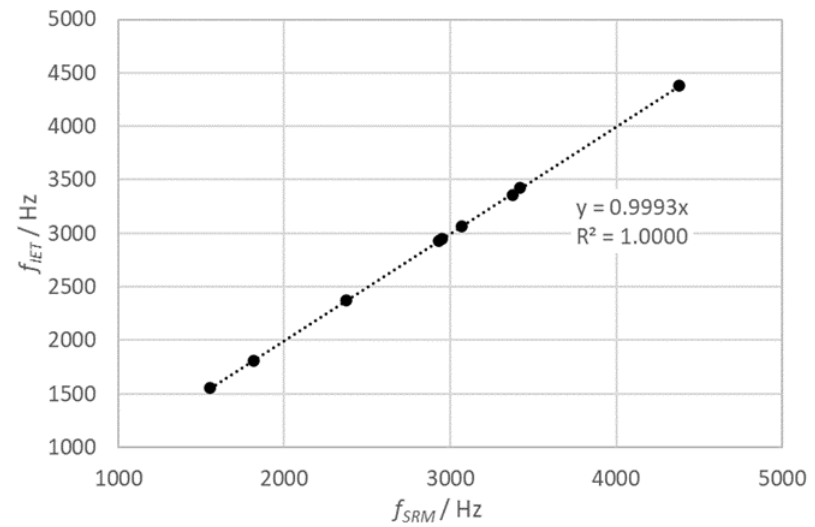
Figure 3. Dependence of resonant frequencies for samples measured by IET and SRM.